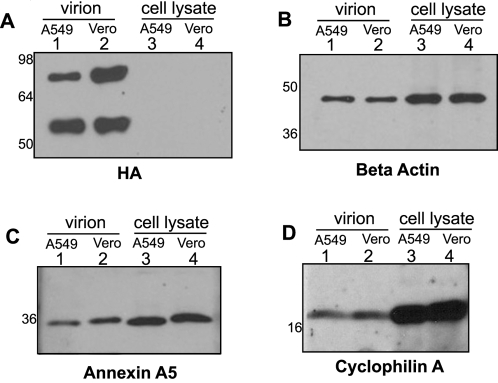
Confirmation of host protein incorporation into influenza virions derived from different cell lines.Influenza A/WSN/33 virus was purified from the supernatant of infected A549 and Vero cells. 2 ug of purified virus derived from A549 and Vero cells (lane 1 and 2, respectively) and 10 ug of cellular extracts from uninfected A549 and Vero cells (lanes 3 and 4, respectively) were subjected to western blot analysis with antibodies against the following proteins: (A) Influenza hemagglutinin (HA0 and HA1 are visible), (B) Beta actin, (C) Annexin A5, (D) Cyclophilin A. Numbers to the left are molecular weight markers.